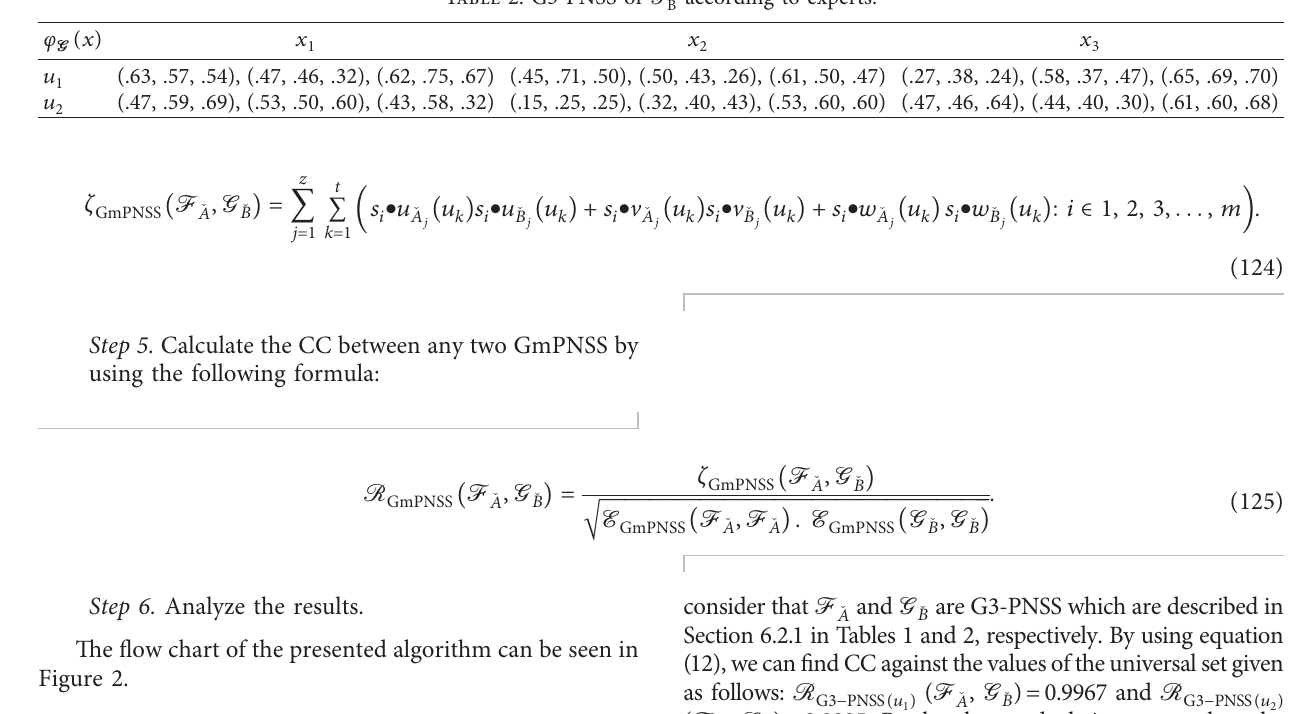
Table 2: G3-PNSS of G